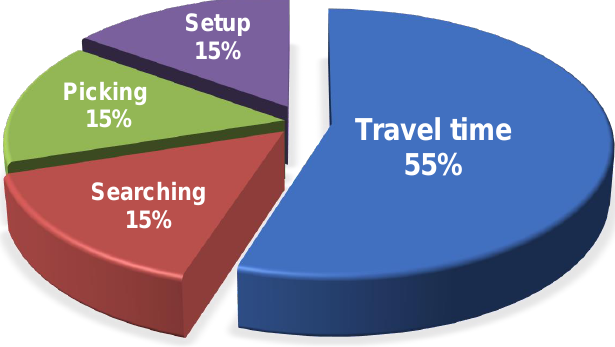
Figure 1. Proportional times for each